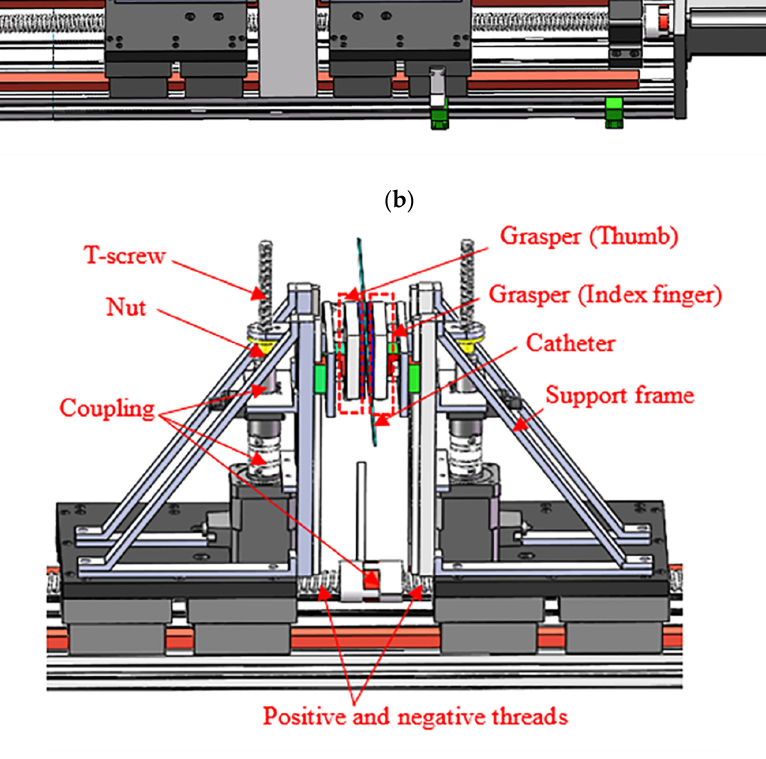
Figure 6. Structural design drawing of the SP. ( a ) Clamping mechanism; ( b ) rotation mechanism; ( c ) internal details of the SP.